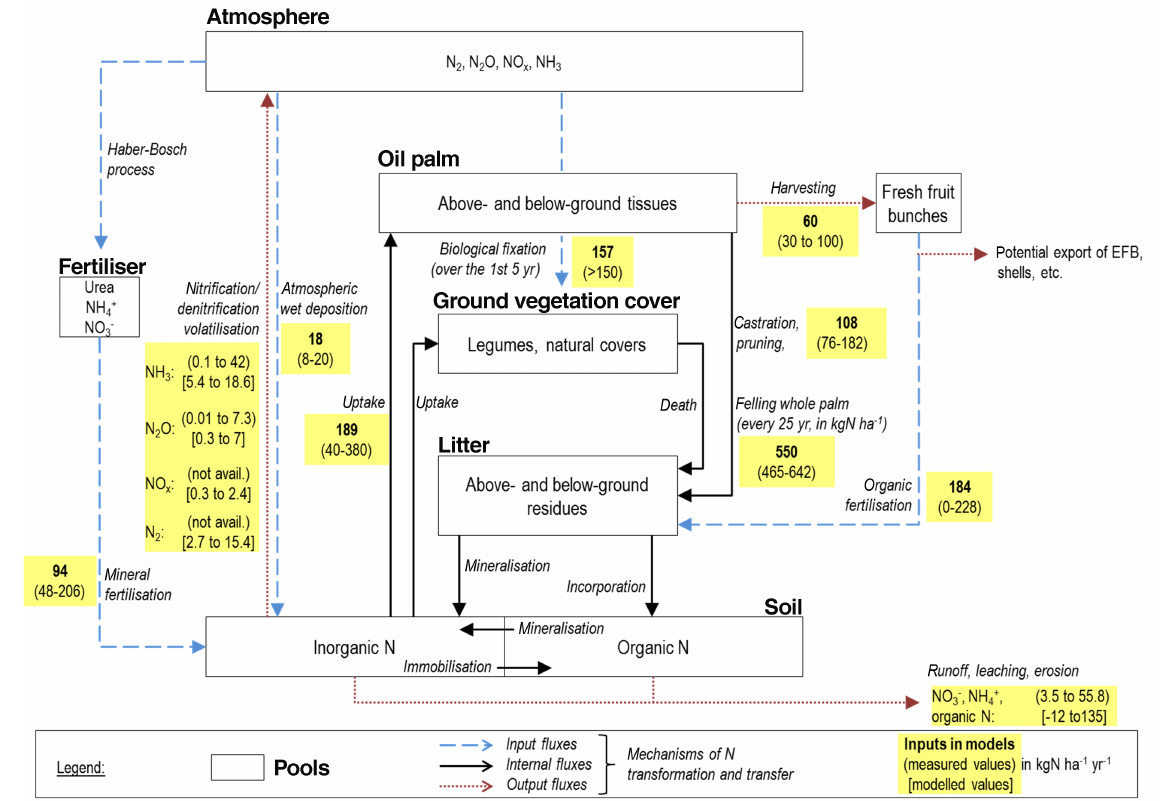
Figure 4. Comparison of measured and modelled N losses in oil palm plantations. The range of modelled values for leaching and runoff was wider than the one of measured values of leaching, runoff, and erosion. Modelled NH 3 volatilisation seemed underestimated; however the maximum value of 42kg Nha − 1 yr − 1 was measured for mineral fertiliser applications of solely urea, while the rate of urea in our scenario was of 25% of mineral fertiliser. Modelled N 2 O emissions were similar to field measurements, although the minimum value was not as low. The pools are represented by the rectangles, and the main fluxes are represented by the arrows. Flux values are ranges given in kg Nha − 1 yr − 1 . Measured values are from Pardon et al. (2016). POME: palm oil mill effluent; EFB: empty fruit